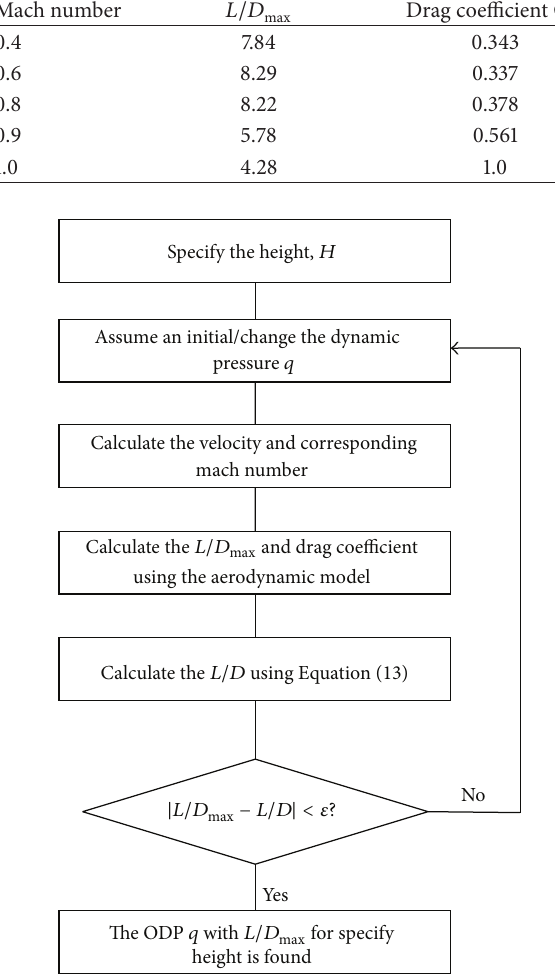
Figure 2: Steps for calculating dynamic pressure with 𝐿/𝐷 max for a specified flight height.